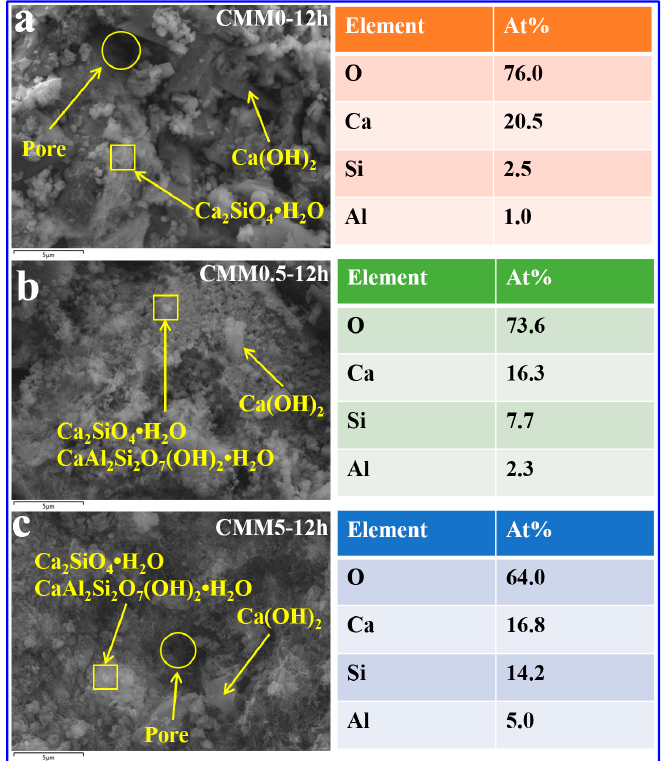
Figure 13. SEM ‐ EDX results of ( a ) CMM0, ( b ) CMM0.5 and ( c ) CMM5 at autoclaved 12 h. Figure 13. SEM-EDX results of ( a ) CMM0, ( b ) CMM0.5 and ( c ) CMM5 at autoclaved 12 h.